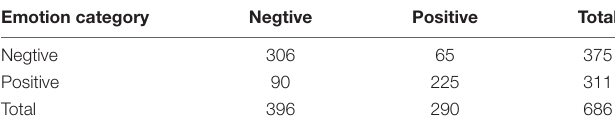
TABLE 3 | MOSI test set Confusion